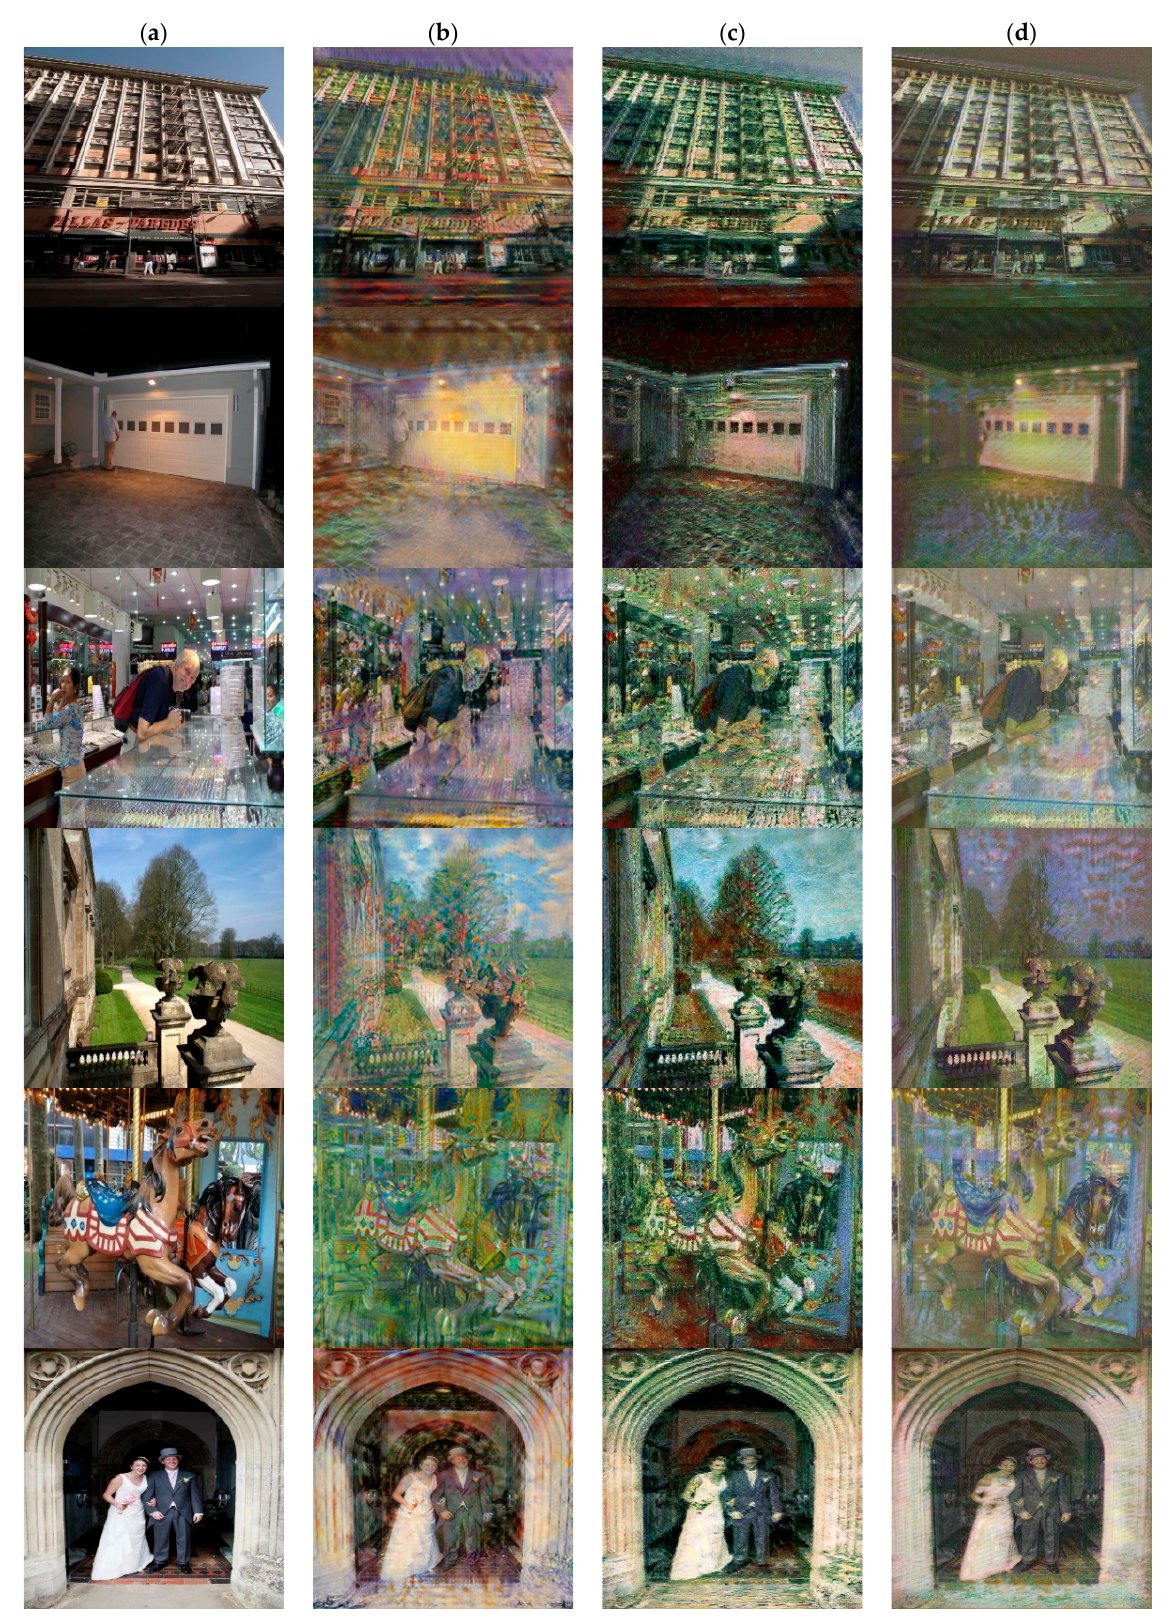
Figure 7. Comparison with different style transfer method based on the Monet style collection. ( a ) Inputs. ( b ) CycleGAN [13]. ( c ) Sanakoyeu et al. [12]. ( d ) Ours.